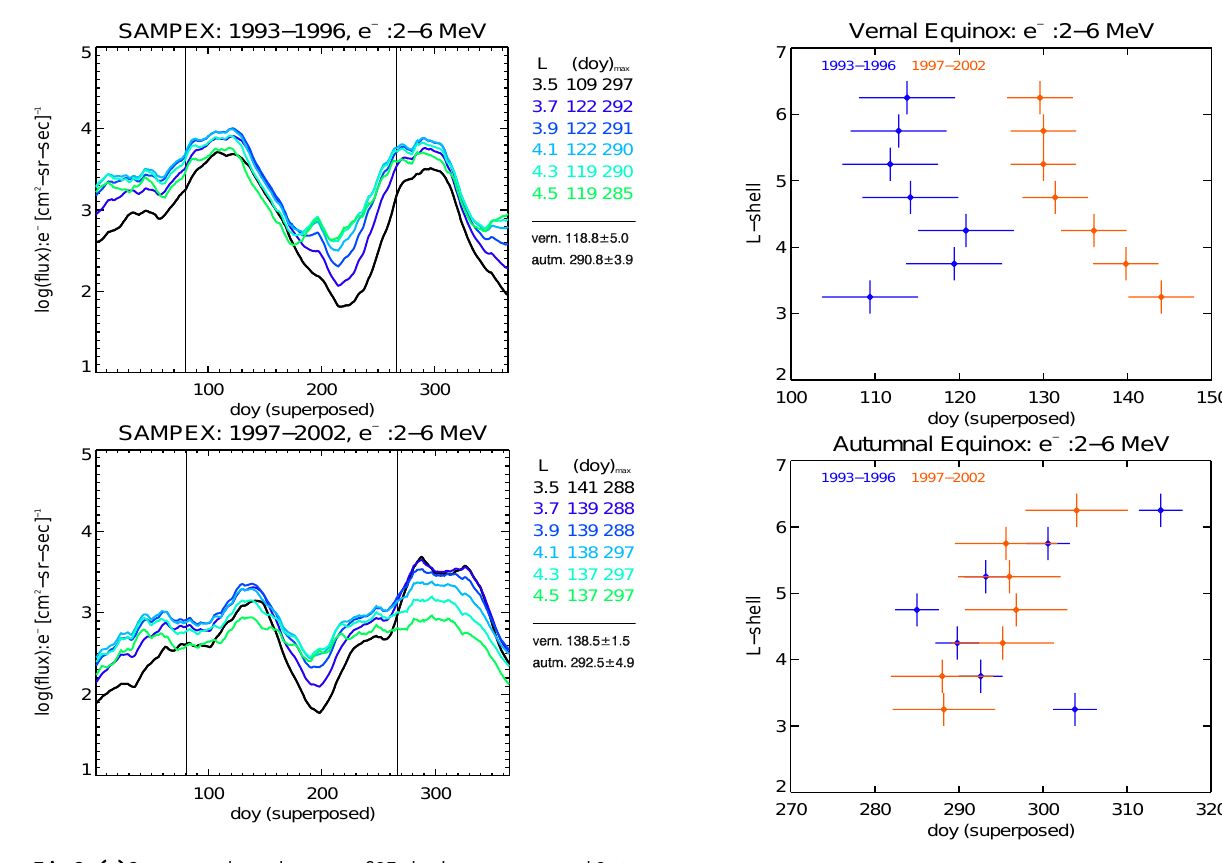
Fig. 4. (a) Observed times of peak fluxes for the 2- to 6-MeV elec- trons as a function of L for the vernal equinox with the descend- ing(ascending) phase shown in blue(red). (b) Similar to (a) but for the autumnal